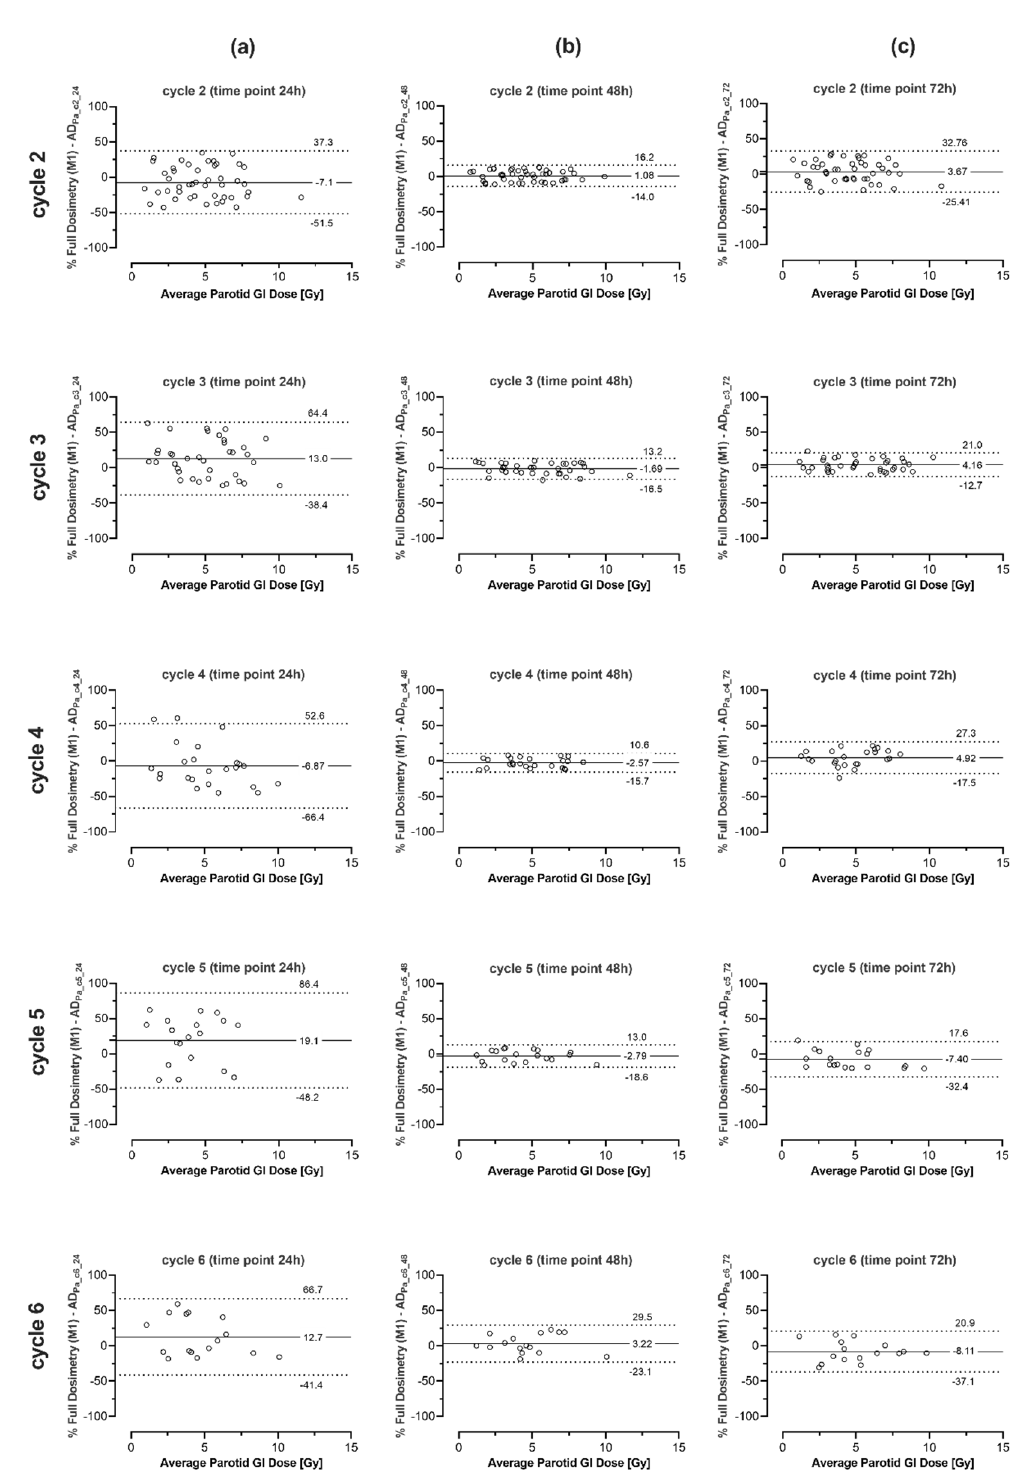
Figure A2. Bland-Altman Analysis comparing calculated absorbed doses of parotid glands using full dosimetric scheme (method 1, used as reference) and streamlined dosimetry (method 2) for therapy cycles 2 to 6 and each single time-point imaging at 24 ( a ), 48 ( b ) and 72 h p.i. ( c )